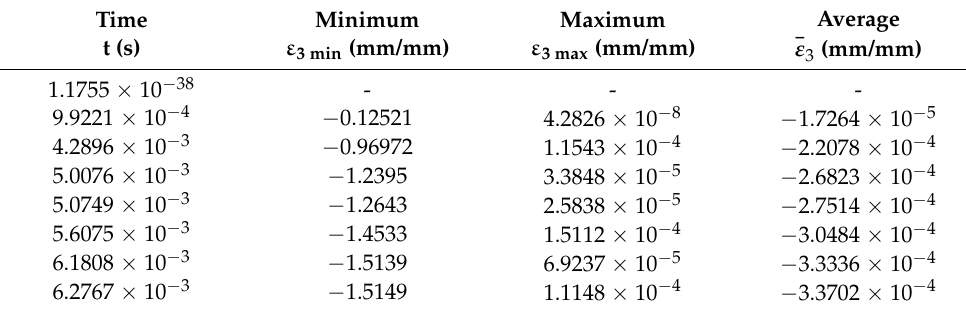
Table 7. Minimum principal elastic strain.